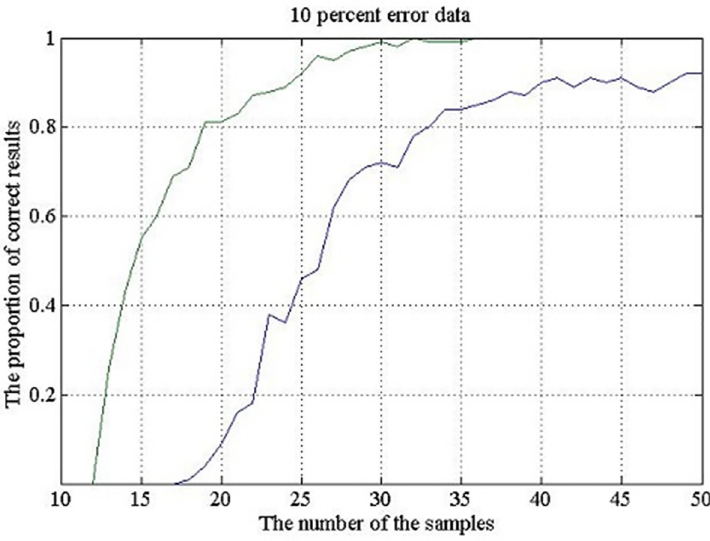
Fig 5. The same as in Fig 4, for fragment sets G (g, 90), i.e., at the data error of 10%. The average number of genome copies in the metagenome is 20; σ = 1. The lower and the upper curves show the percentage of correct answers at the number of different genomes 15 and 10,